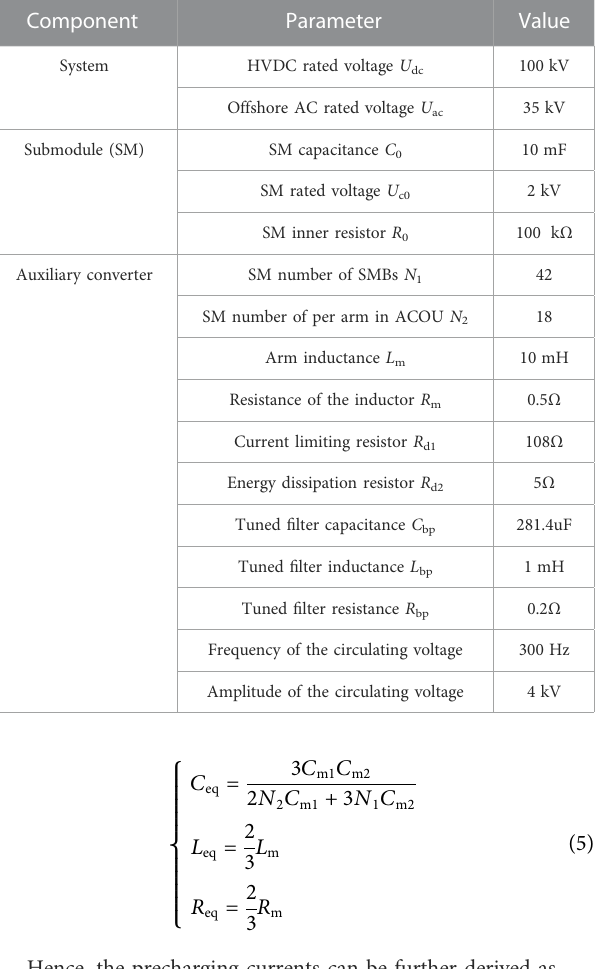
FIGURE 7 Comparison of the precharging current between calculation and